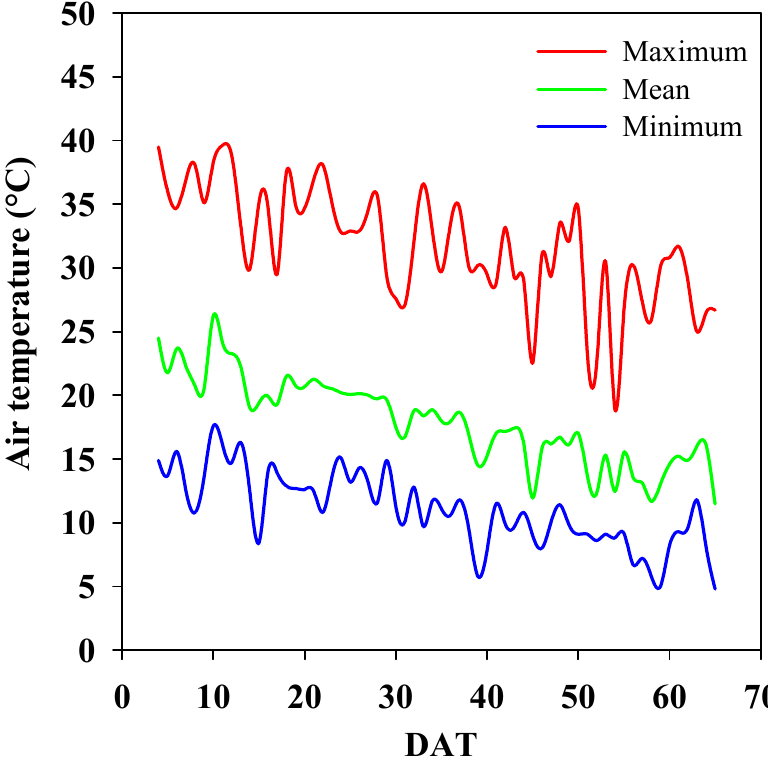
Figure 1. Daily maximum, mean, and minimum values of air temperature recorded inside the greenhouse during the growing period of lettuce.